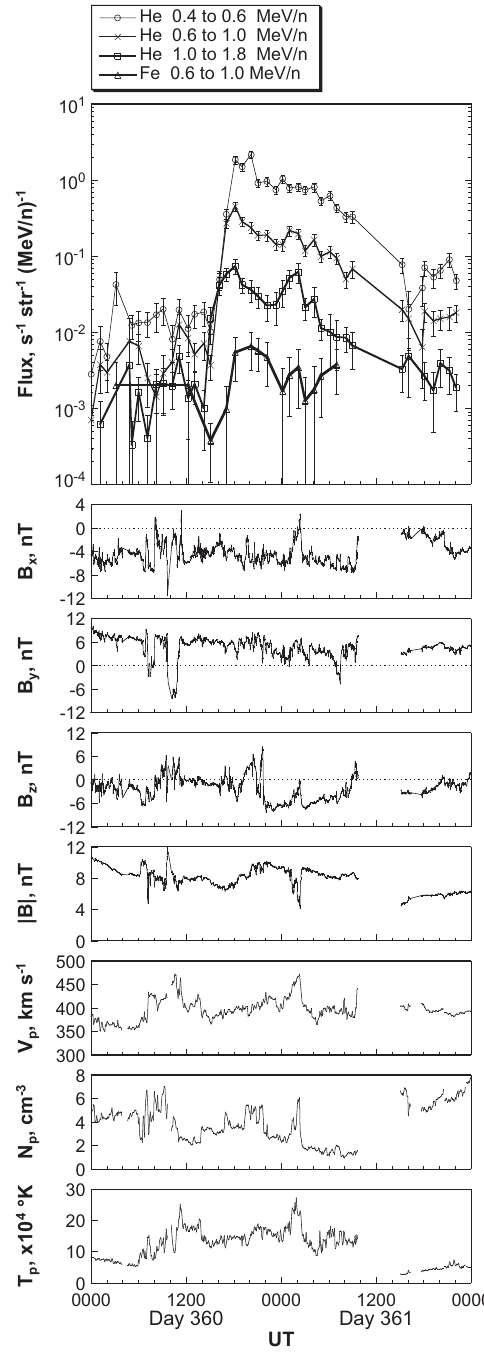
Fig. 4. He ( 3 He+ 4 He) flux, plasma and magnetic field data for the 26 December 1978